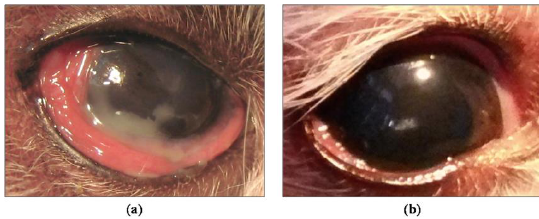
Figure 1. Results of periglandular MSCs (mesenchymal stem cells or multipotent stromal cells) implantation in severe and refractory canine keratoconjunctivitis sicca. ( a ) Before implantation; ( b ) After 9 months of treatment.